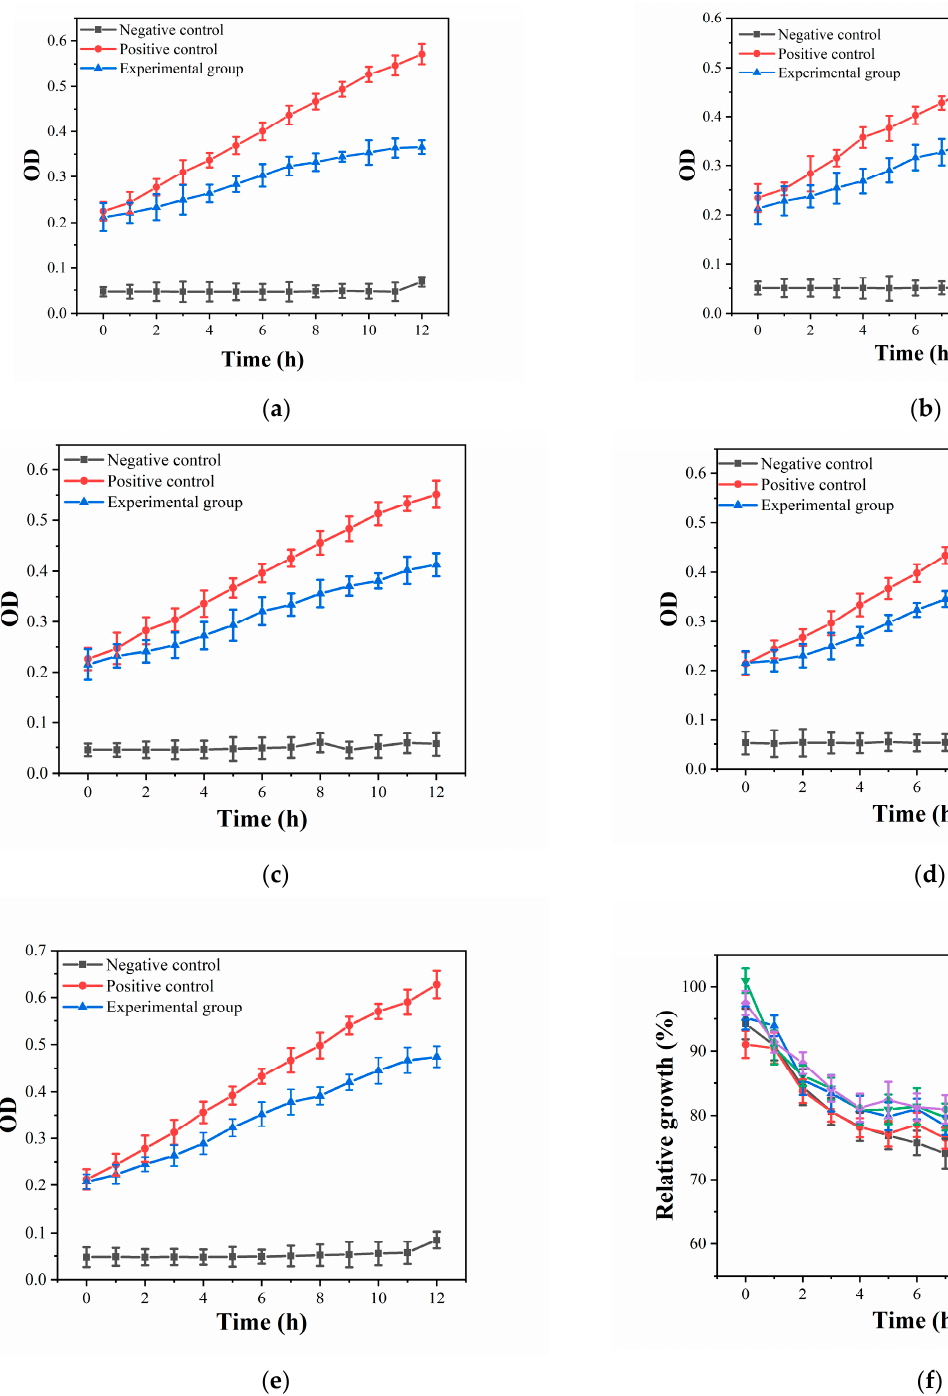
Figure 2. Growth curves of V. harveyi in epidermal mucus and nutrient solution at different temperatures: ( a ) 17 °C, ( b ) 21 °C, ( c ) 24 °C, ( d ) 27 °C, and ( e ) 31 °C. ( f ) A comparison of the increase in the number of V. harveyi in crucian carp epidermal mucus under five temperature cultures. Values are represented as mean ± SD of pooled data from triplicates per treatment ( n = 3). Means in the same row with different letters are significantly different ( p < 0.05).